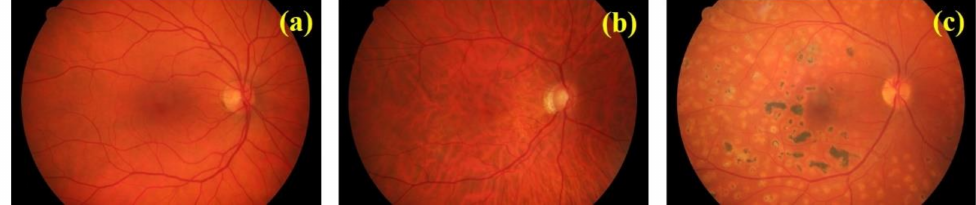
Figure 1. Retinal images from the dataset corresponding to a healthy ( a ), glaucomatous ( b ), and diabetic retinopathy ( c )